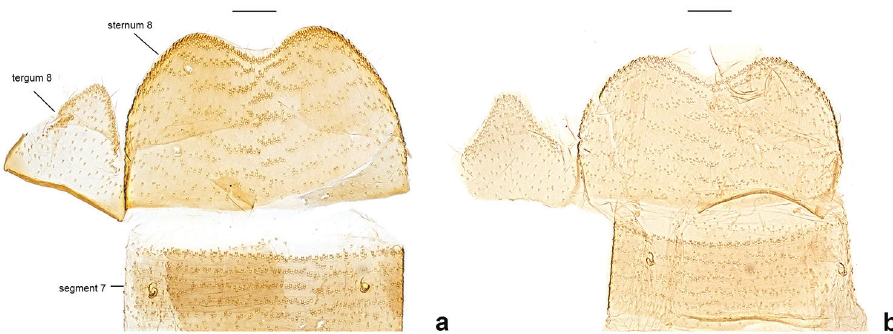
Figure 4. Last abdominal segment of male Neopalpa species. a N. neonata (specimen BIOUG01860-D04, dissection MIC6545; CA: San Diego County) b N. donaldtrumpi sp. n. (UCIS 313268, dissection VNZ556; CA: Riverside County). Scale bar 100